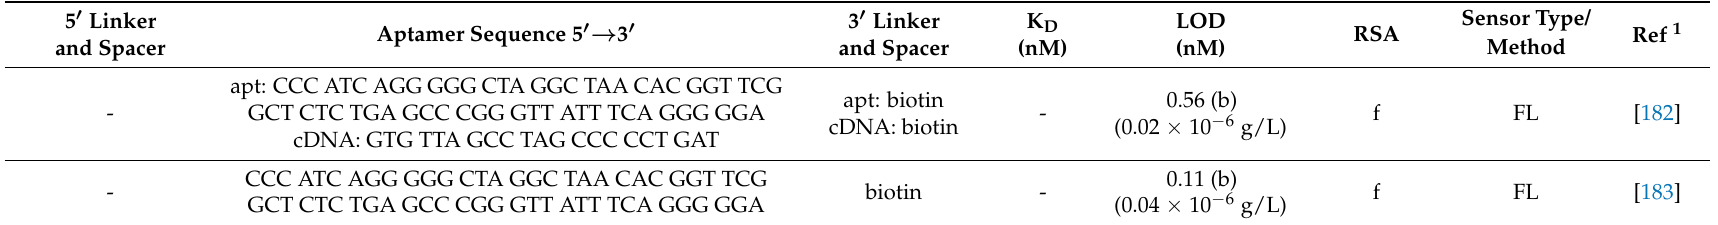
Table 12. Aptamer sequence, dissociation constant (K D ), limit of detection (LOD), real sample analysis (RSA), and realized sensor type and measuring method for enrofloxacin, mentioned in the corresponding references (Ref). apt = aptamer, b = buffer, cDNA = complementary DNA, and FL = fluorometric.